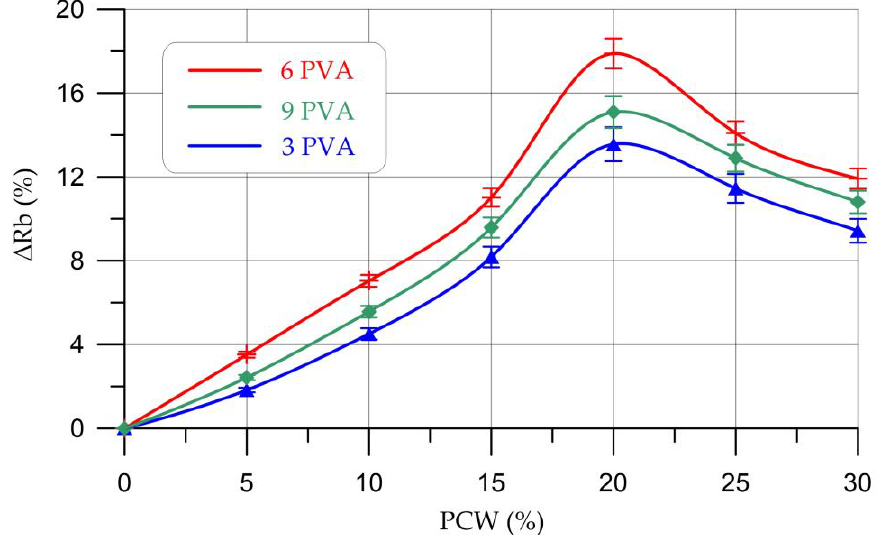
Figure 7. Changes in compressive strength (∆ R b ) of geopolymer composites depending on the content of PCW and PVA.